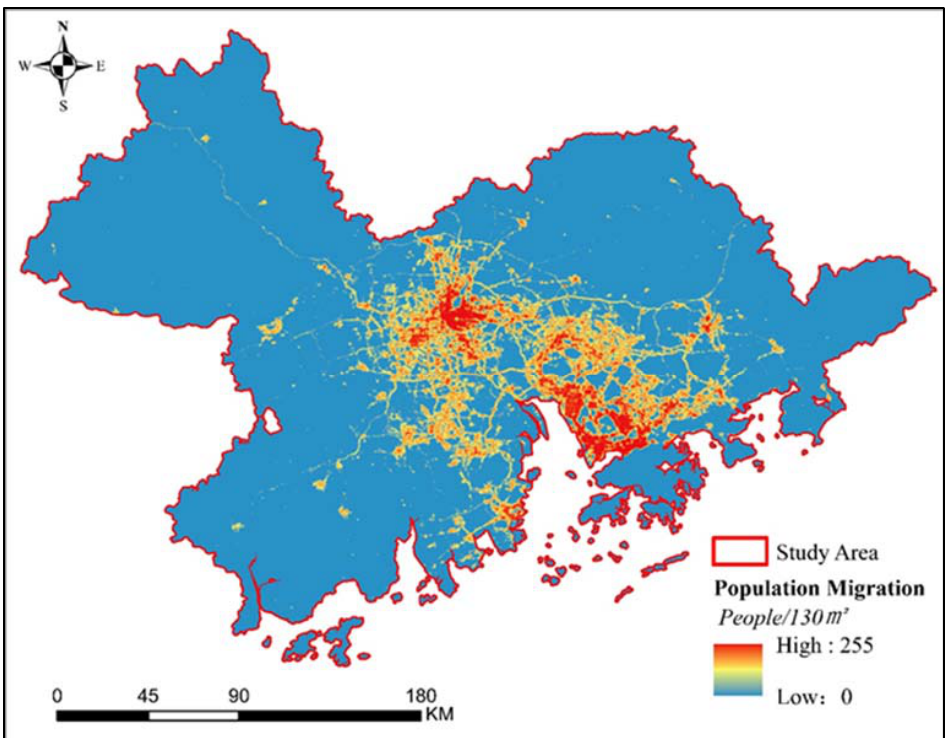
Figure 4. Preprocessing result of population migration data.